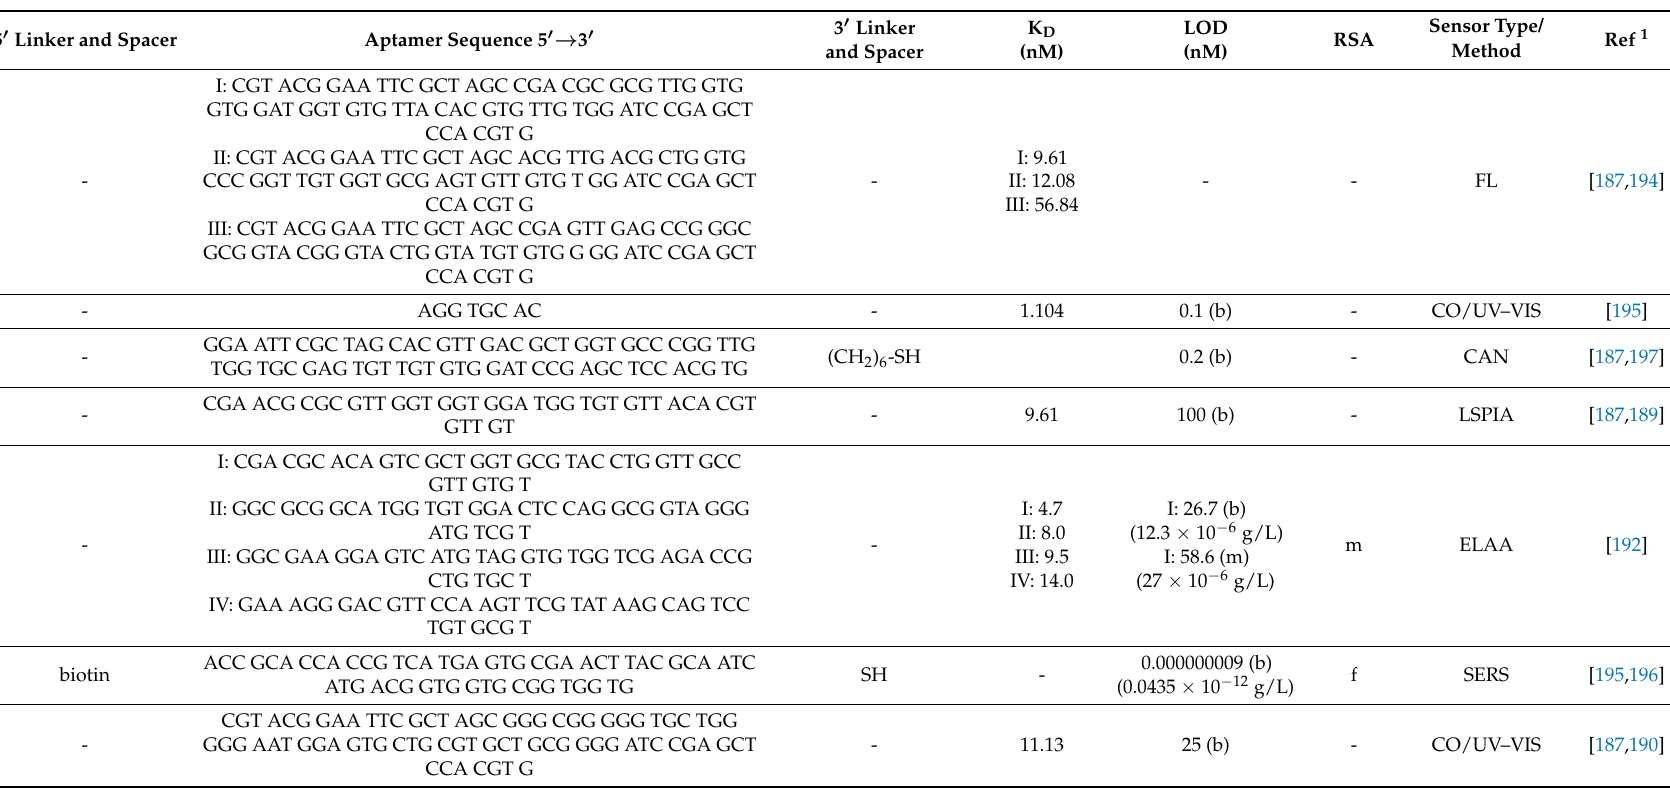
Table 15. Aptamer sequence, dissociation constant (K D ), limit of detection (LOD), real sample analysis (RSA), and realized sensor type and measuring method for oxytetracycline, mentioned in the corresponding references (Ref). AEC = amperometric electrochemical, apt = aptamer, b = buffer, CAN = cantilever, cDNA = complementary DNA, CO = colorimetric, CV = cyclic voltammetry, d = drugs, DPV = differential pulse voltammetry, ECL = electrochemiluminescent, EIS = electrochemical impedance spectrometry, ELAA = enzyme-linked aptamer assay, f = fish, FAM = fluorescein amidite, FL = fluorometric, h = honey,